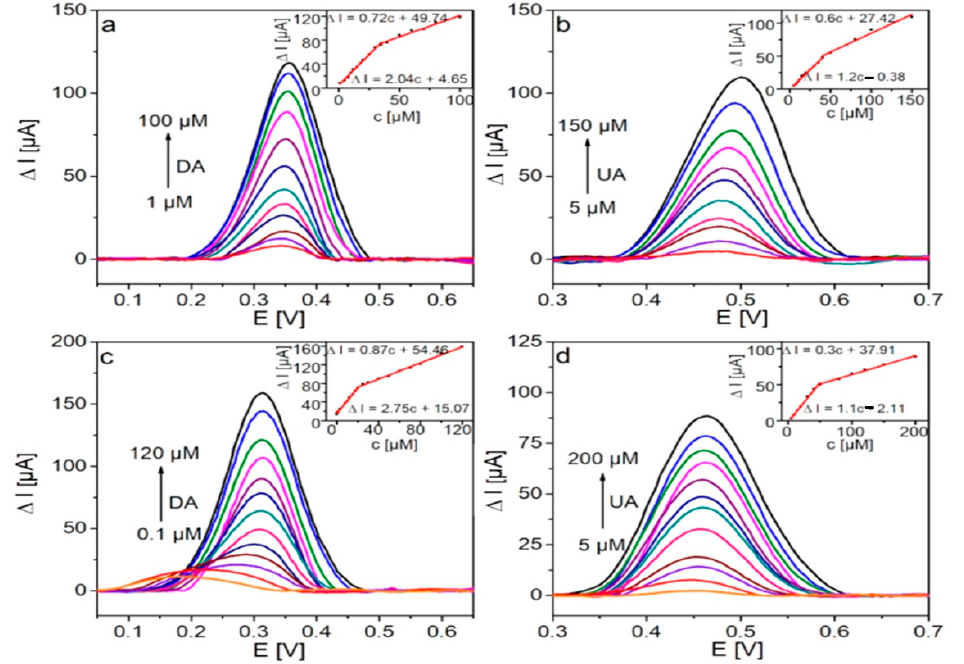
Figure 6. DPV curves recorded with ( a , b ) GCE/FSG and ( c , d ) GCE/PFSG in the presence of ( a , c ) DA in 0.1 M PBS (pH 7.0) and ( b , d ) UA in 0.1 M PBS (pH 6.6). Insets show corresponding calibration curves.